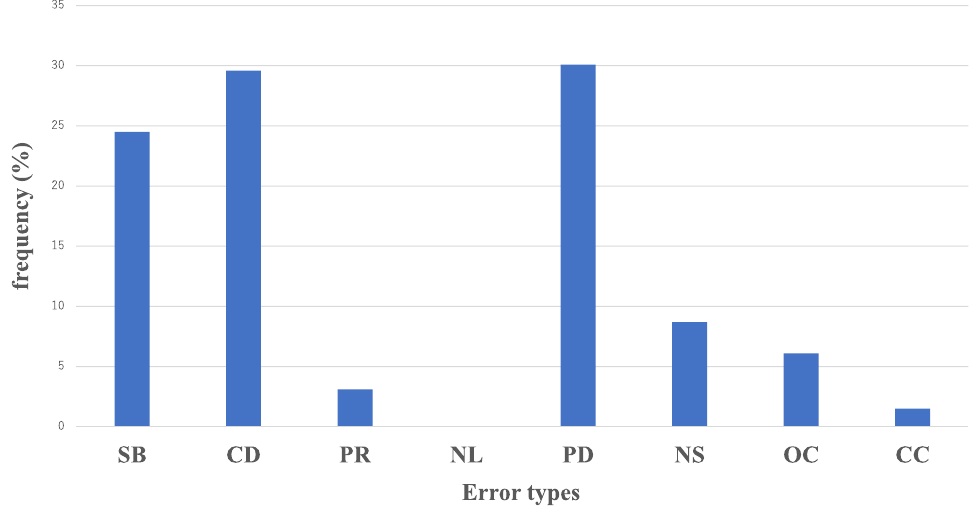
Figure 1. Frequencies of error types on the Clock Drawing Test. SB stimulus-bound response, CD conceptual deficit, PR perseveration, NL neglect of left hemi-space, PD planning deficit, NS nonspecific spatial error, OC numbers written on outside of the clock, CC numbers written counterclockwise.